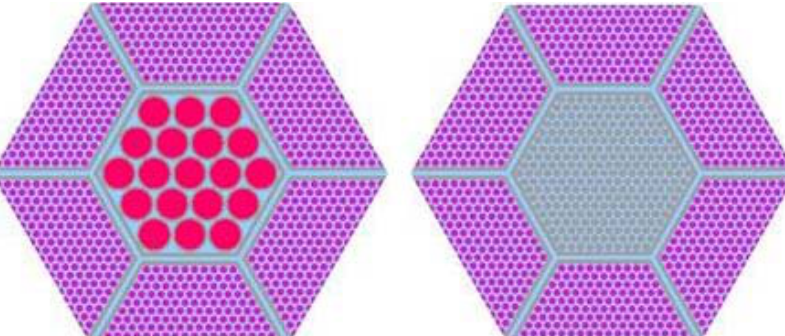
Figure 6. Example for Super-cell